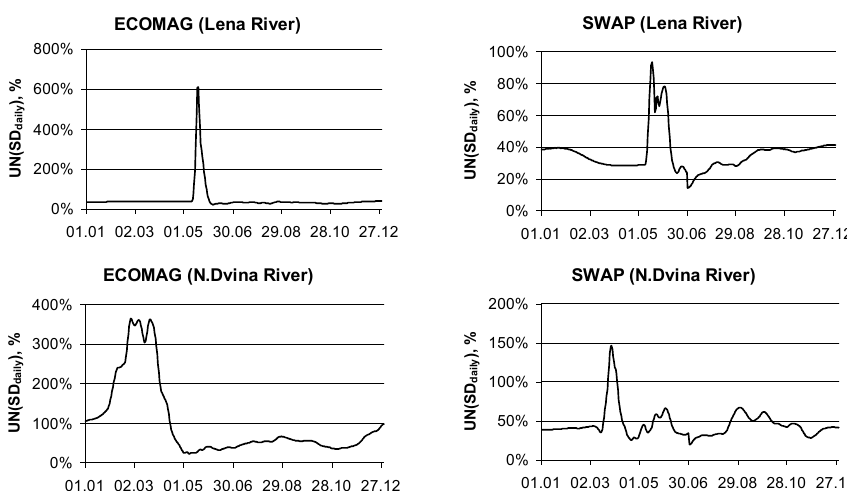
Figure 8. Uncertainty indices UN(SD) (in %) for the SD estimates of the daily runoff.